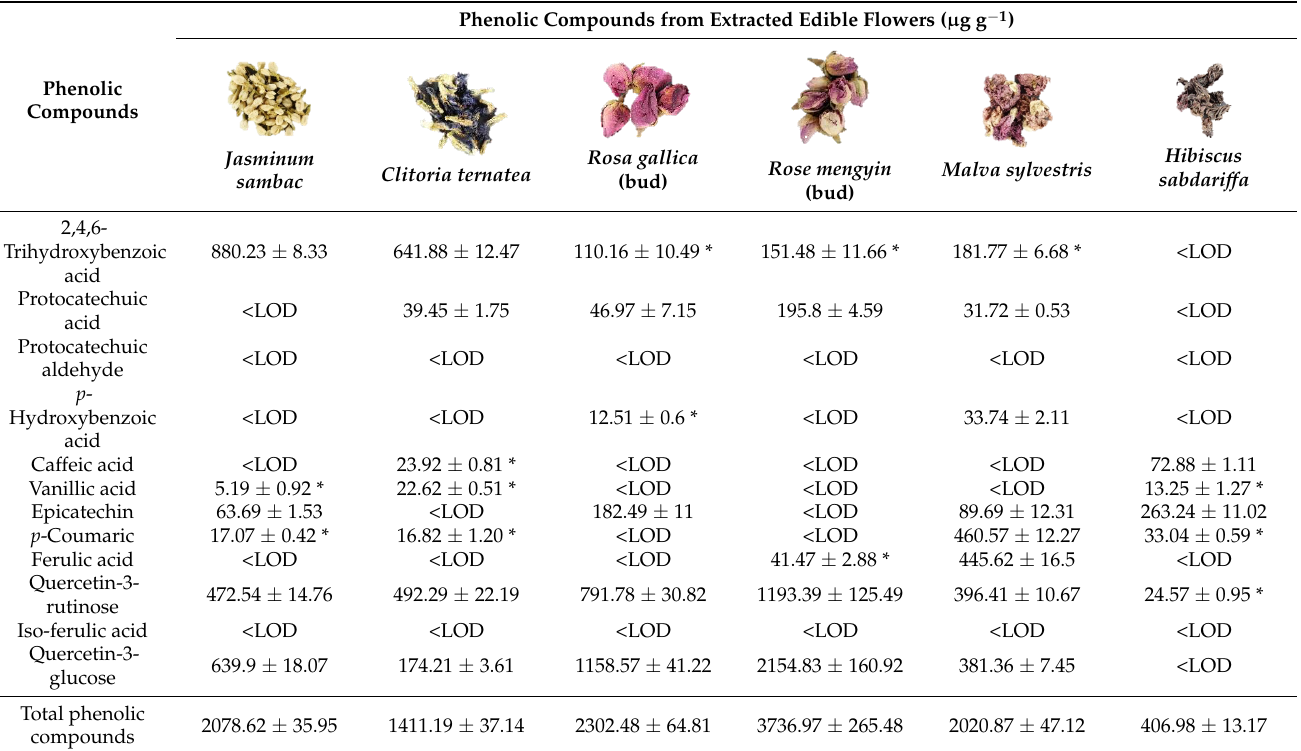
Table 5. Individual phenolic compounds from different dried edible flowers. Table 4b. Individual phenolic compounds from different dried edible flowers ( Table 4b. Individual phenolic compounds from different dried edible flowers ( continue)